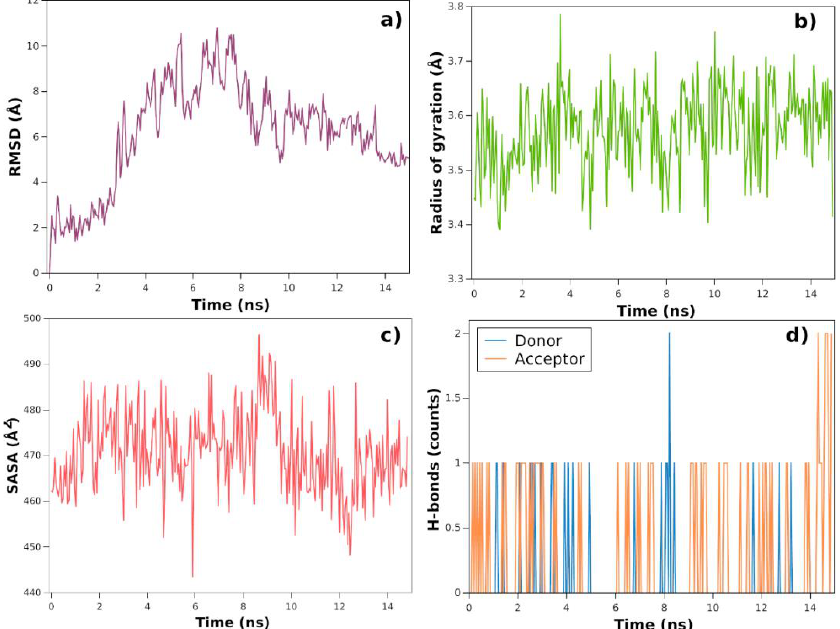
Figure 8. Molecular dynamics analysis using RMSD values over time ( a ), the radius of gyration over time ( b ), solvent-accessible surface area over time ( c ), and number of H-bonds whether protein as donor or acceptor ( d ).